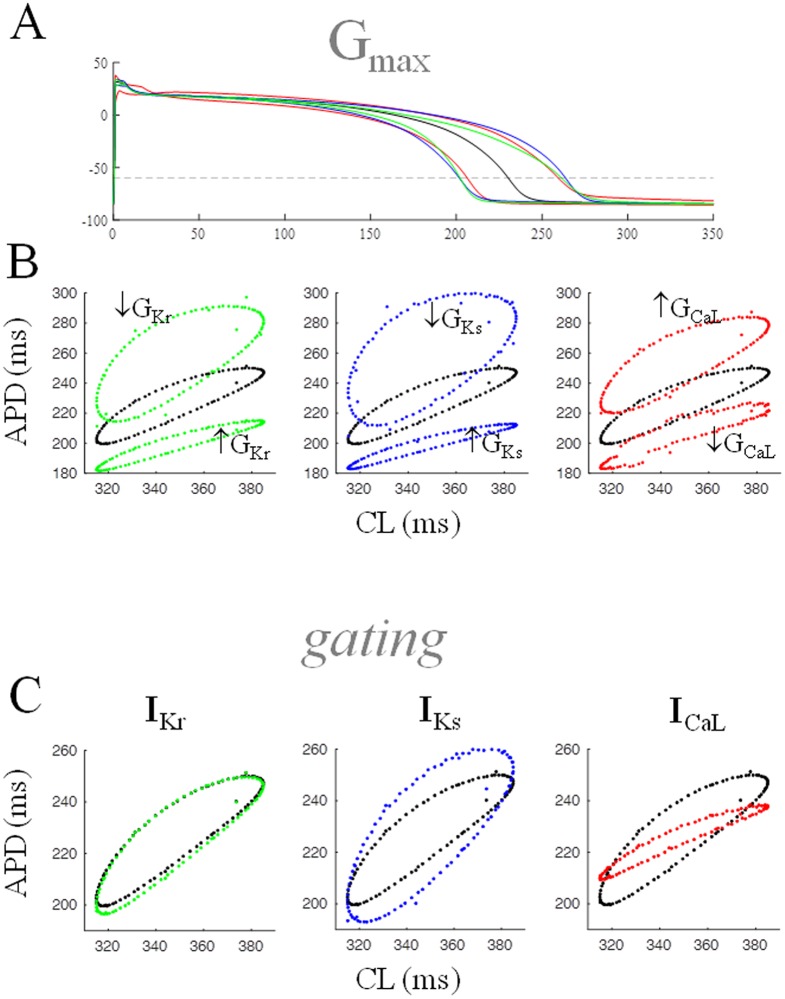
Role of voltage and time-dependence of ion currents.(A) TP06 AP waveform under constant pacing at CL = 350 ms is shown (black), together with modified waveforms obtained by decreasing or increasing GKr, GKs, and GCaL (green, blue, and red respectively) in order to obtain ±12.5% APD changes. (B) Control and modified (as in A) AP waveforms underwent periodic pacing with CL* = 350 ms, clv = 35 ms, and ɷ = 2.4, and the corresponding space of dERCL states are shown in black and in color respectively. (C) Removal of time-dependency did not produce changes in the space of dERCL states in the case of IKr, almost doubled the size of space of dERCL states in the case of IKs, and nearly abolished it in the case of ICaL.